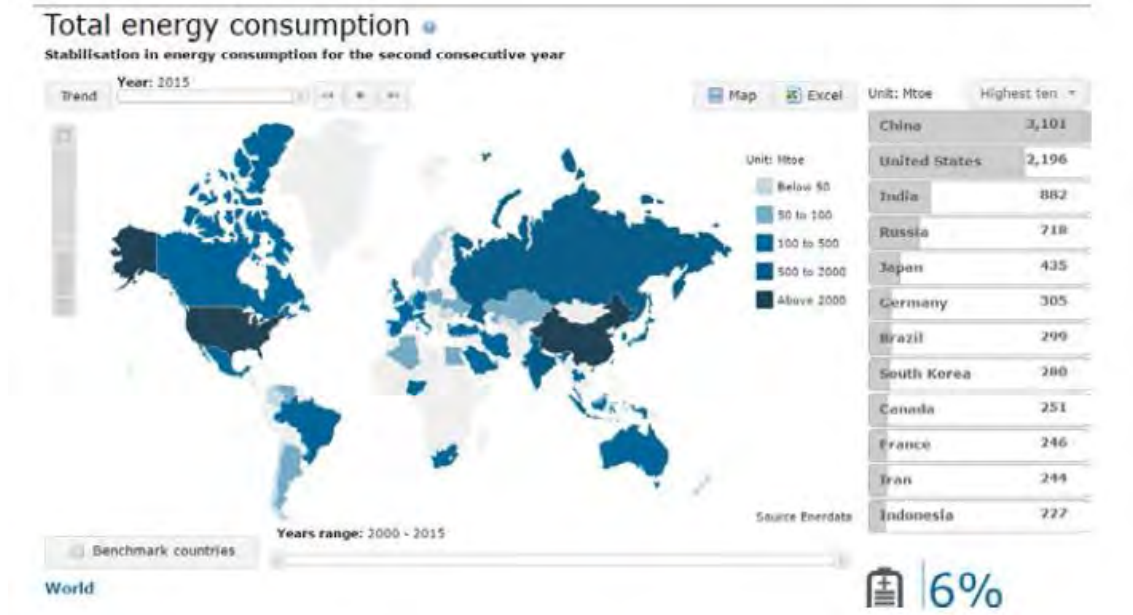
Figure 1. World Total Energy Consumption Data 2015 which shows that Indonesia ranks 10th. With 3% of energy use addition each year. (Source: